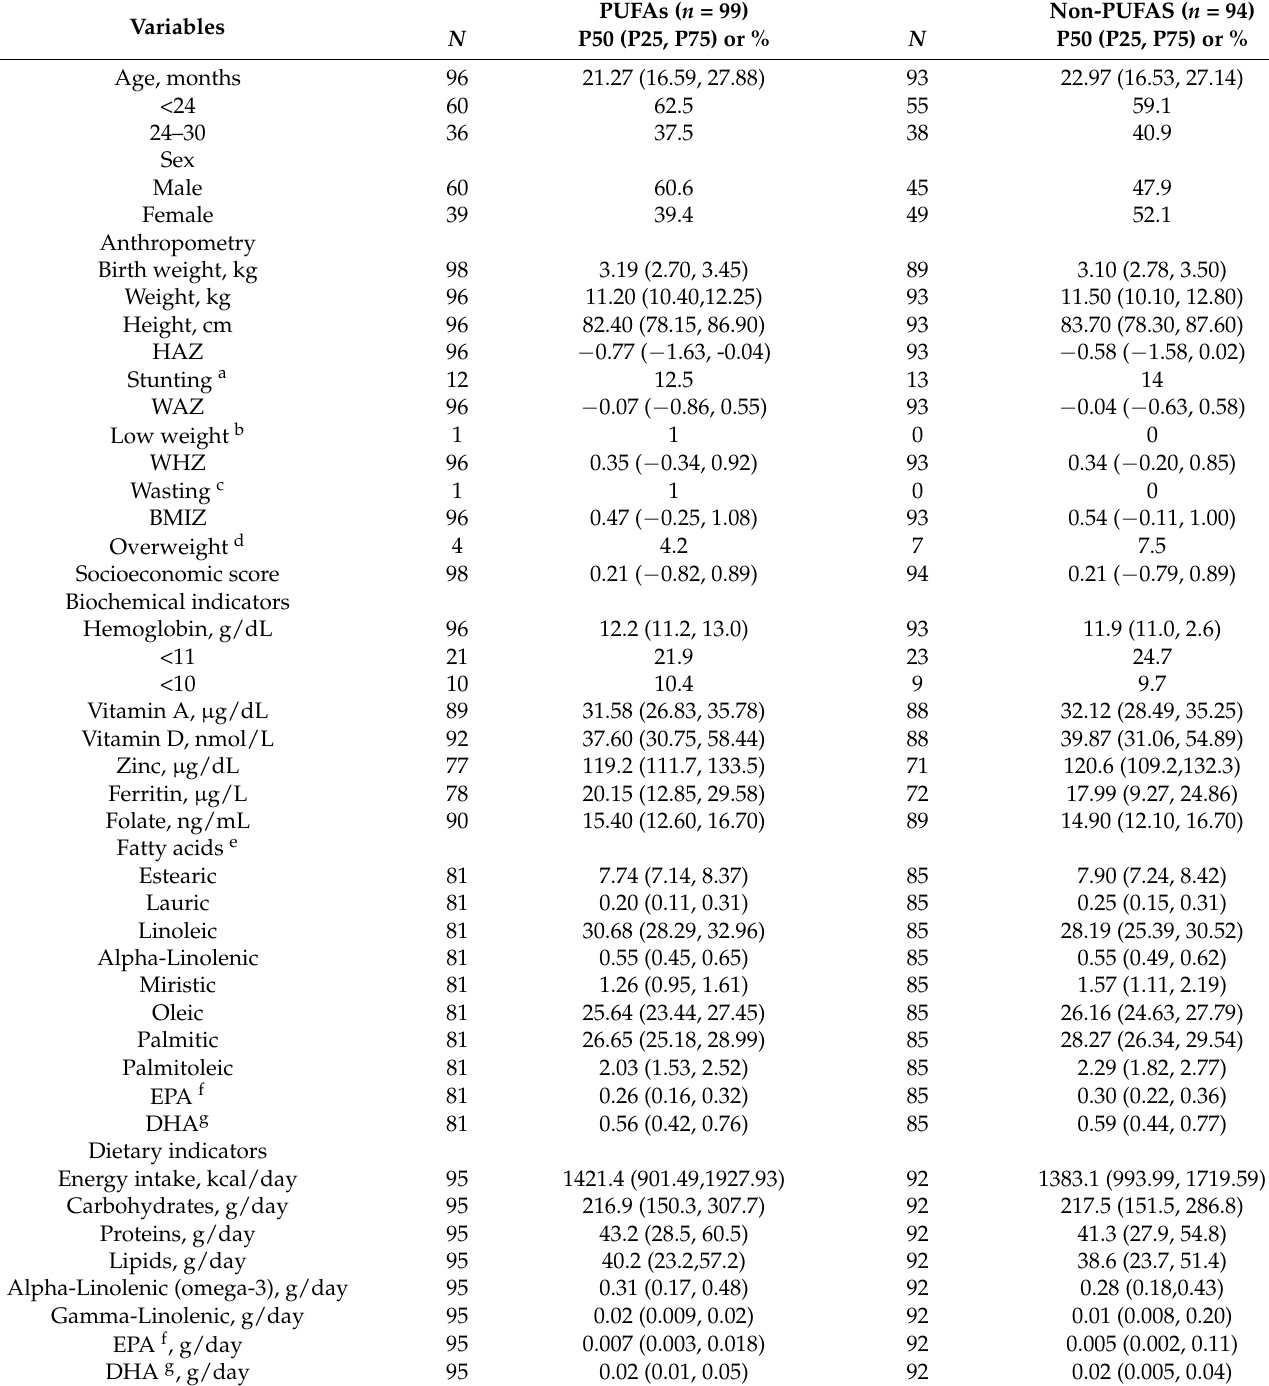
Table 2. Baseline characteristics of infants who completed the study, by treatment group.